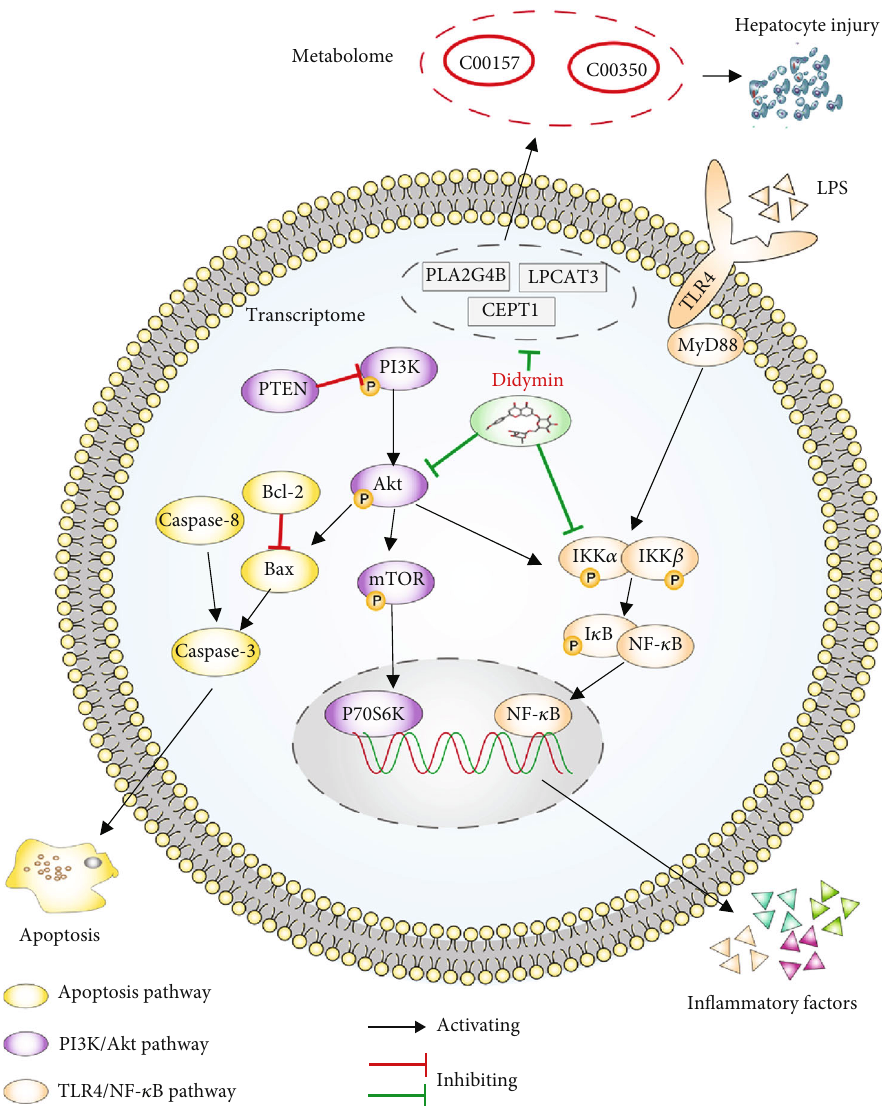
Figure 11: Didymin alleviates LPS/D-Gal-induced ALI in mice by inhibiting the PI3K/Akt and TLR4/NF- κ B signaling pathways as well as the glycerophospholipid metabolism